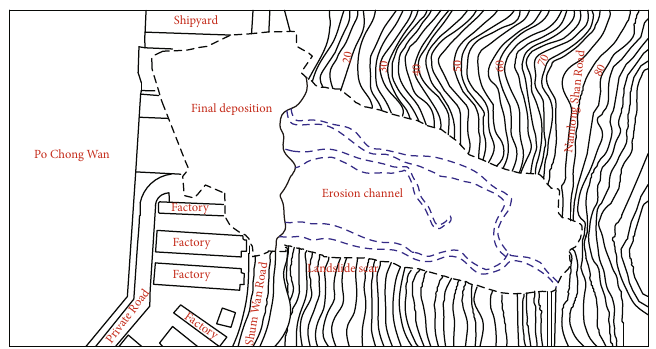
Figure 2: The map of the Sum Wan Road landslide (modi fi ed from Knill 1996).